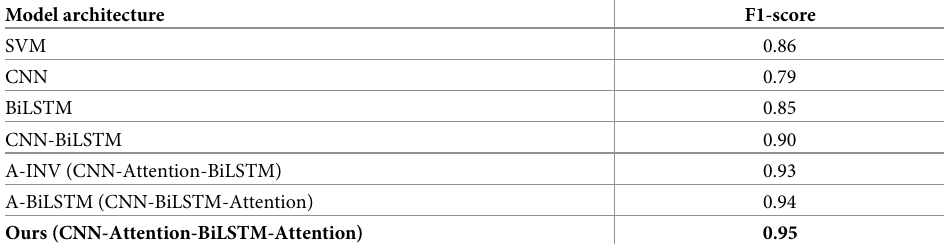
Table 4. The model performance by architecture (locomotion). Our model yielded the highest